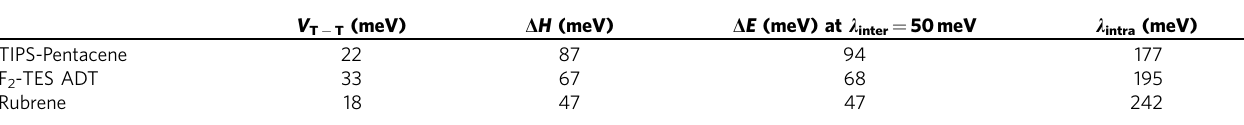
Electronic coupling for triplet transfer V T (cid:3) T , enthalpy of 1 (TT) separation D H , activation energy D E and intramolecular reorganization energy for triplet diffusion l intra , in units of meV. Details in the Methods